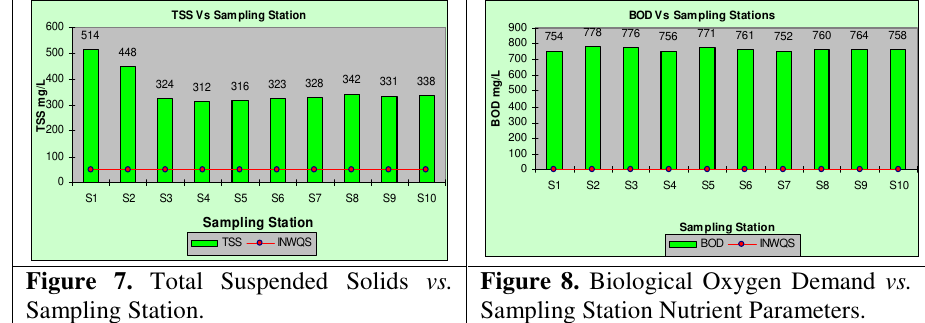
Figure 7. Total Suspended Solids vs. Sampling Station.